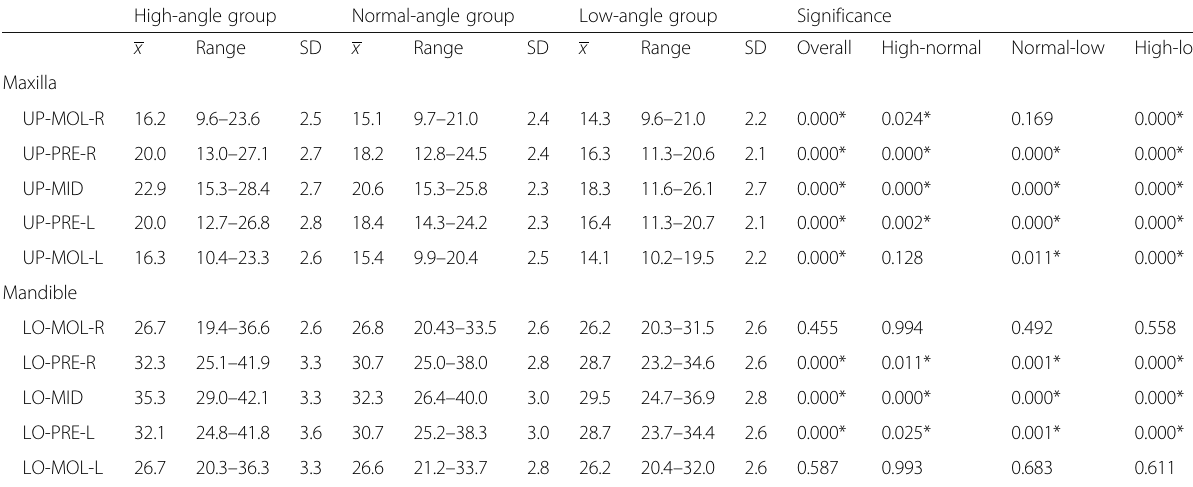
Table 1 Bone height measurements of the maxillary and mandibular body in millimeters High-angle